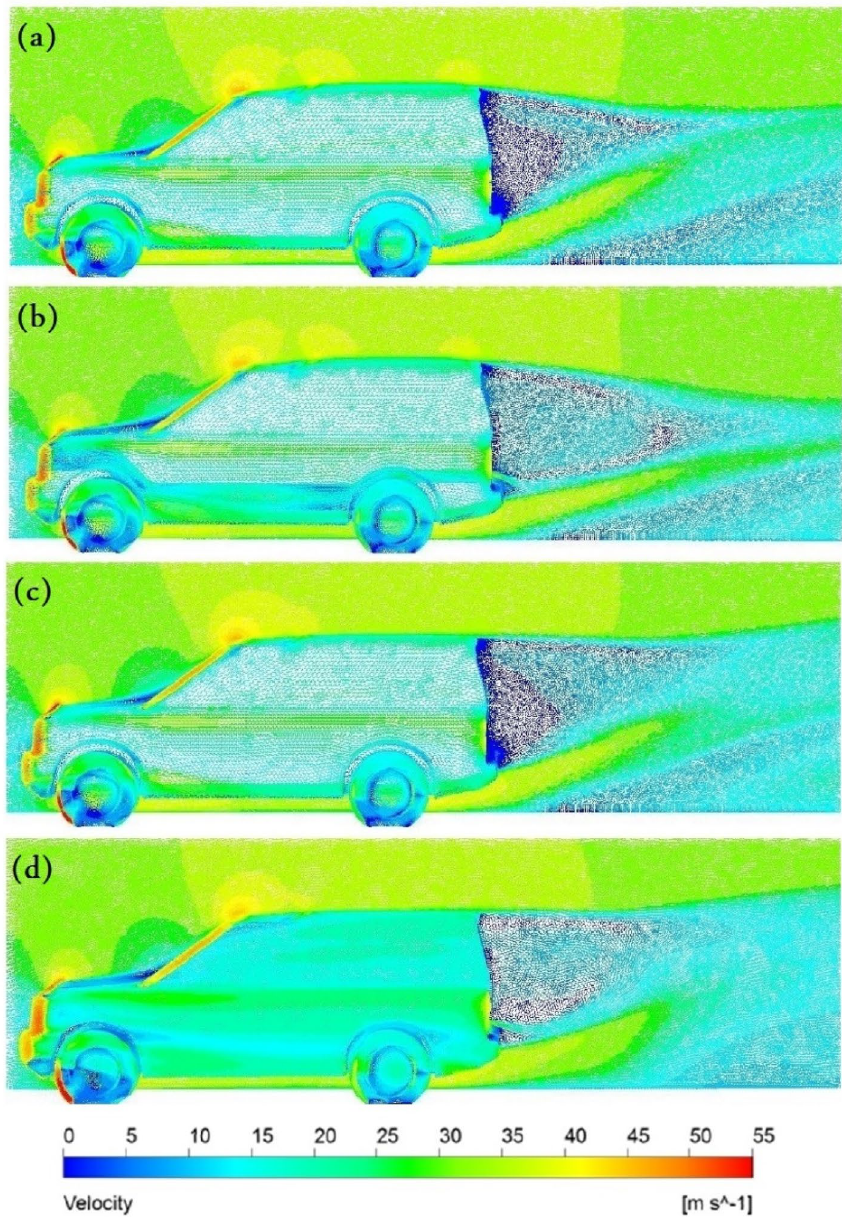
Figure 14. Velocity vectors for ( a ) the baseline model, ( b ) the ventilation duct, ( c ) the roof modified model, ( d ) modified combined